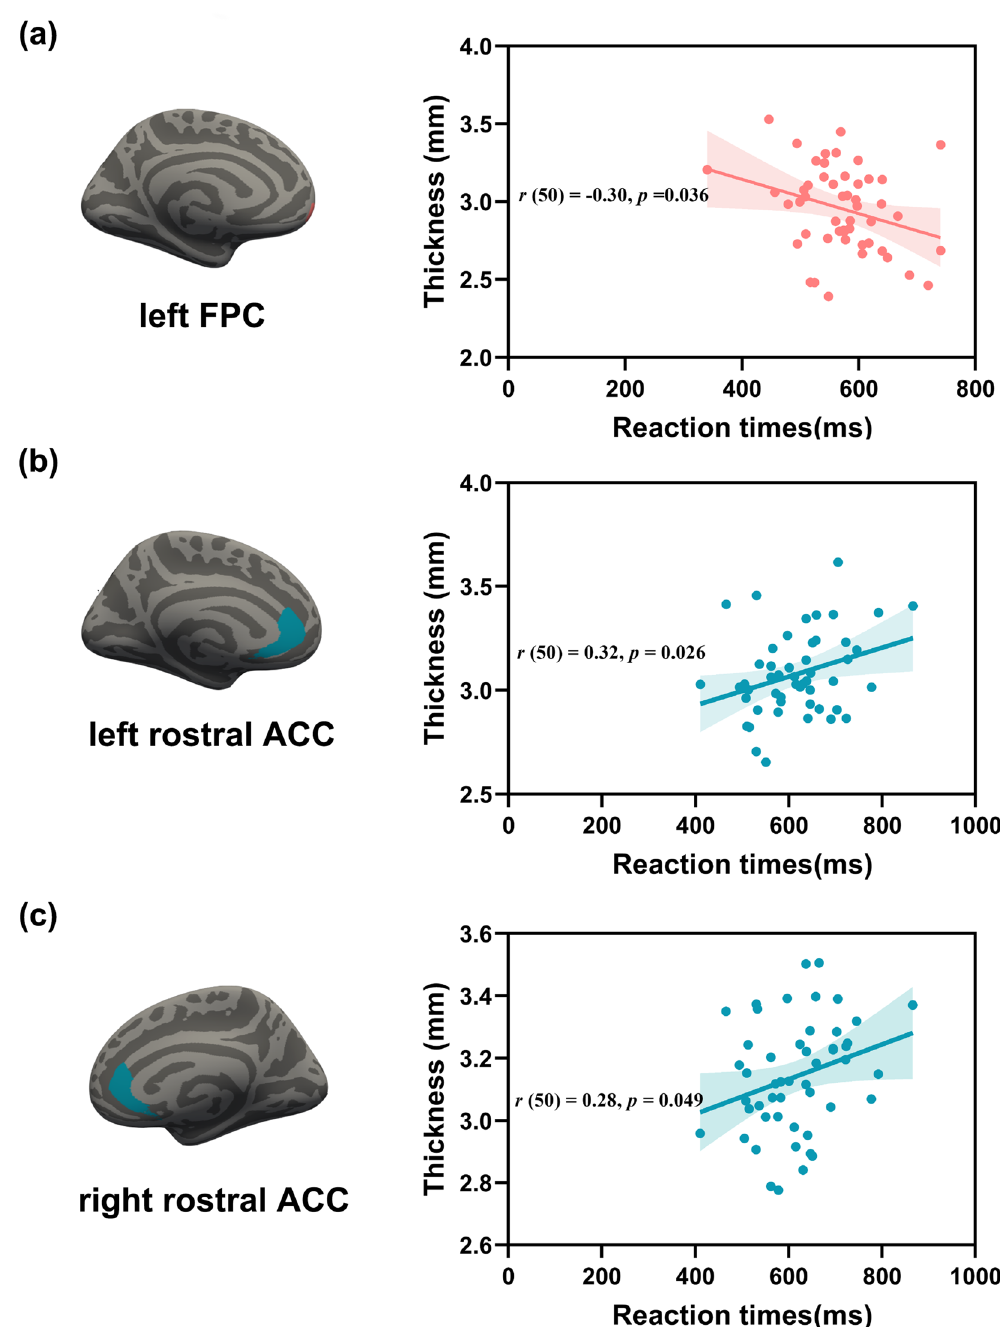
Figure 2. Behavioral SPE-related cortical thickness of ROIs. ( a ) The RTs of the allocentric judgment task in near space were negatively related to the thickness of the left frontal pole cortex ( p = 0.036). ( b ) The RTs of the egocentric judgment task in far space were positively related to the thickness of the left rostral anterior cingulate cortex ( p = 0.026). ( c ) The RTs of the egocentric judgment task in far space were positively related to the thickness of the right rostral anterior cingulate cortex ( p =